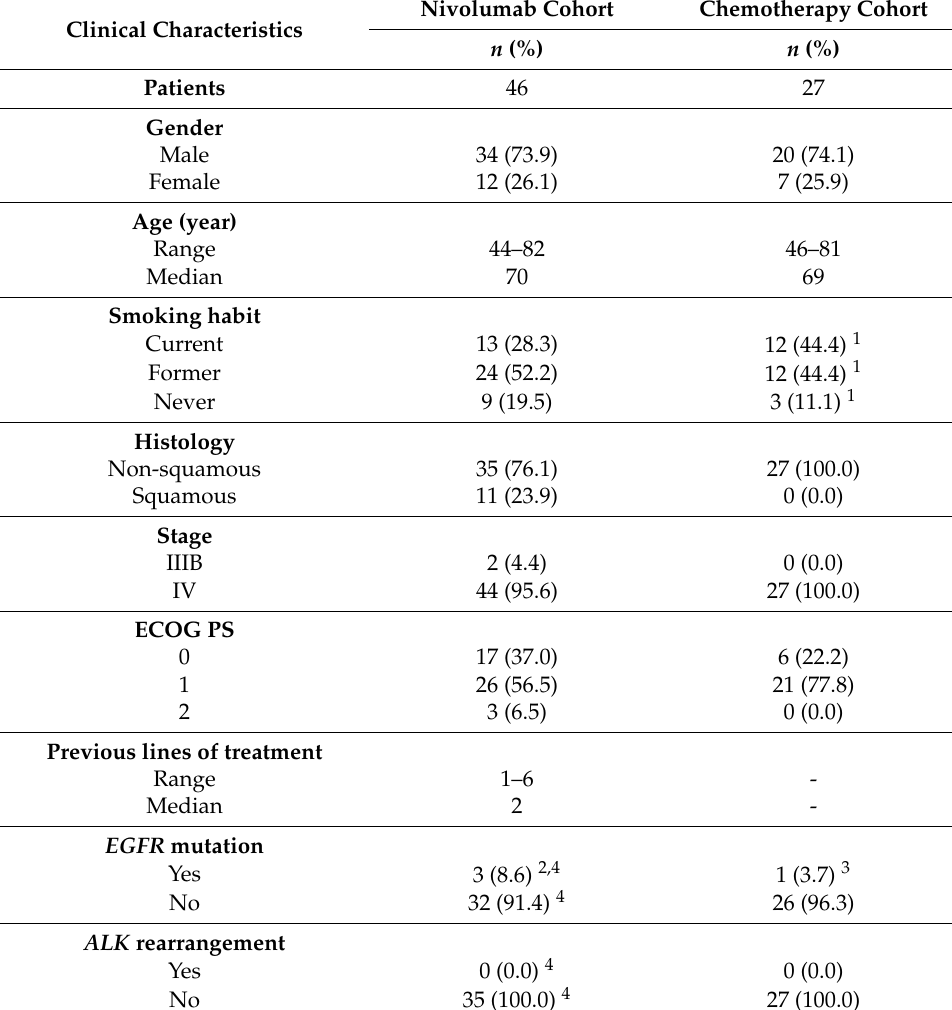
Table 1. Clinical and molecular characteristics of the evaluable patients in the Nivolumab Cohort and in the Chemotherapy Cohort. The Chemotherapy Cohort included only chemotherapy-naïve patients a ff ected by non-squamous NSCLC with ECOG PS =